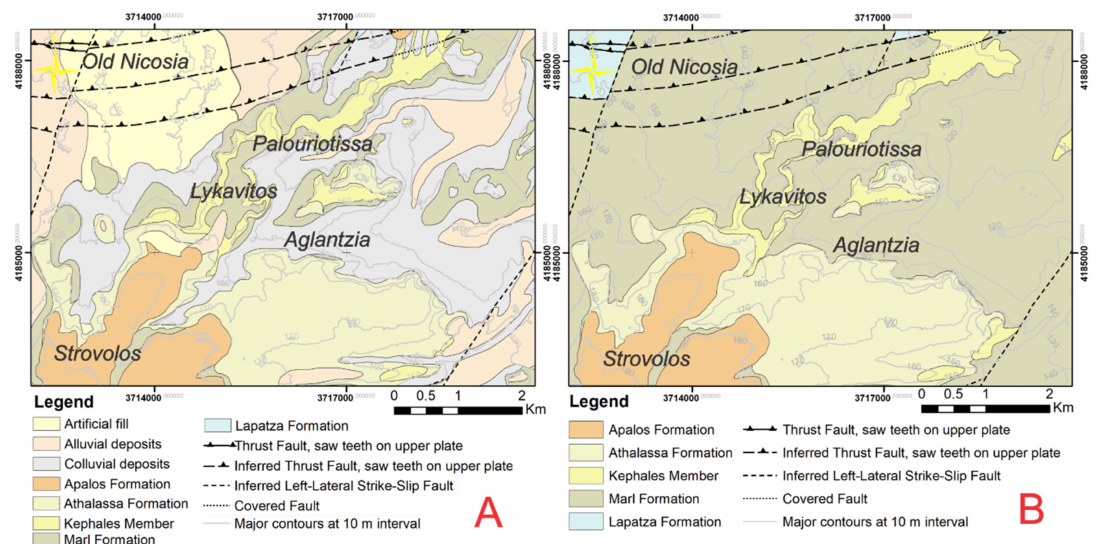
Figure 2. Maps of: ( A ) surficial and ( B ) bedrock geology of the study